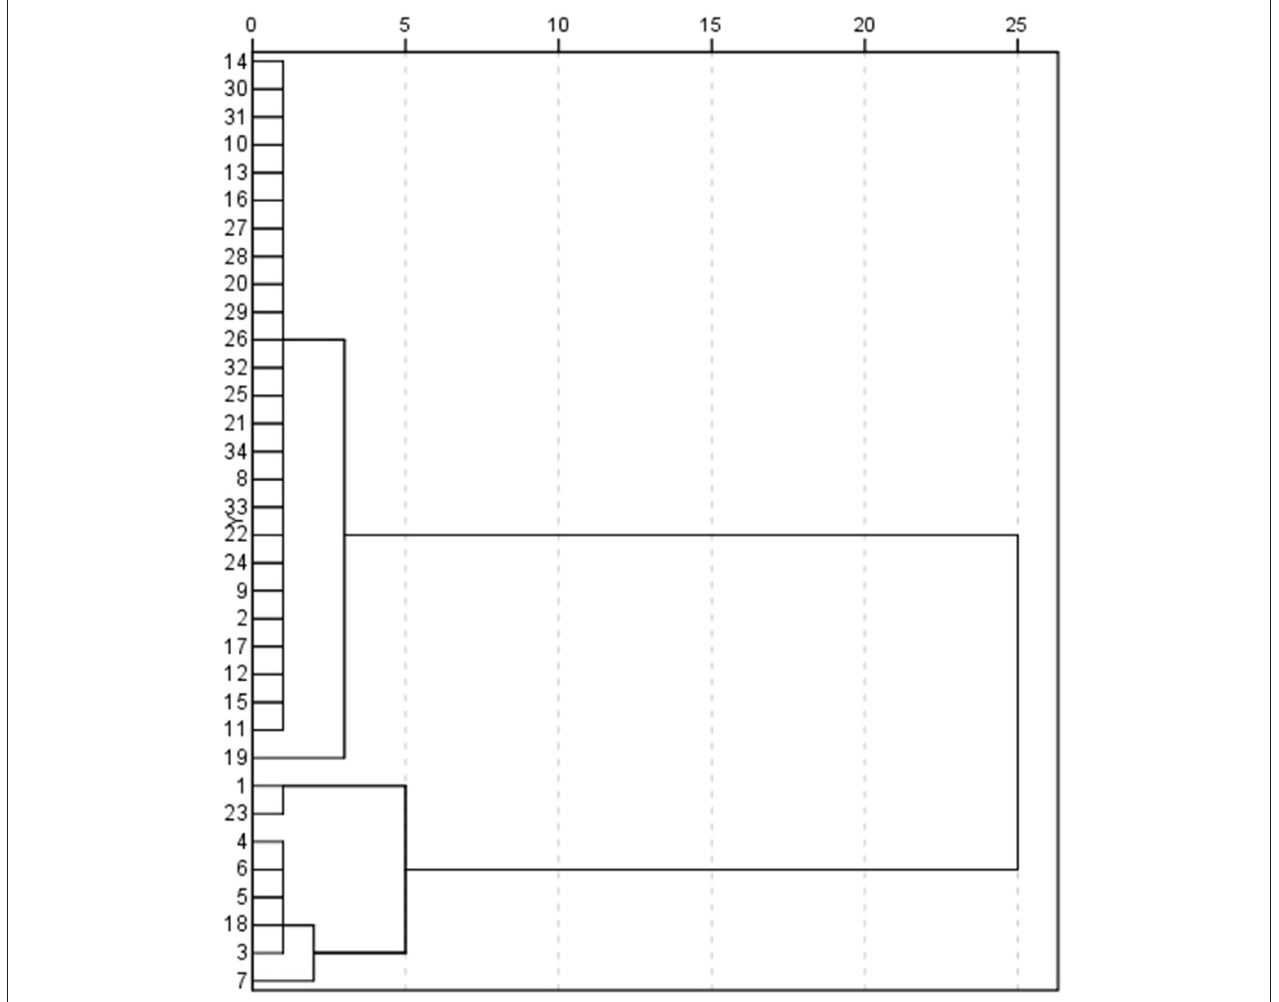
FIGURE 4 | Clustering tree of the sampling point.